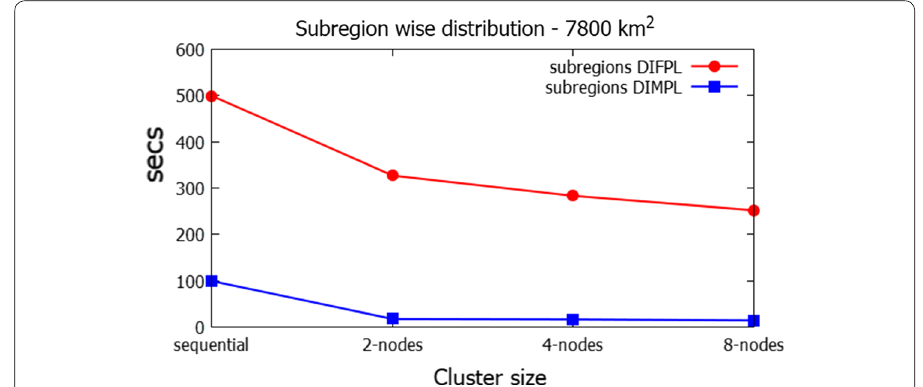
Fig. 17 Performance of subregion‑wise distribution in MapReduce and Spark for various sized clusters